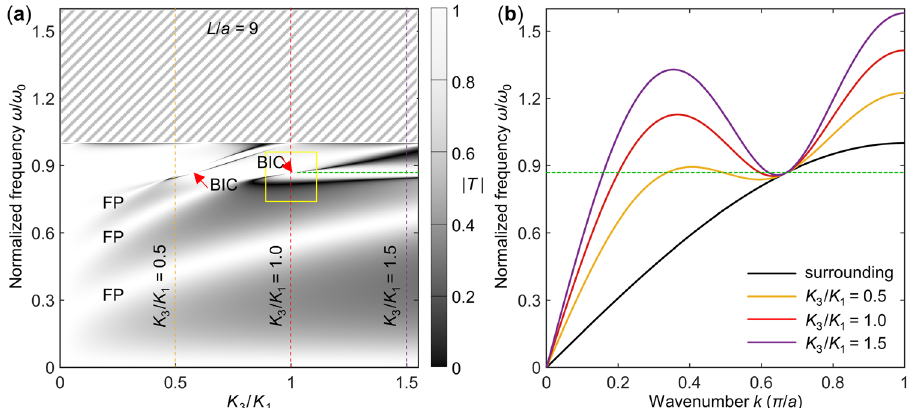
(cid:1) (cid:1) (cid:1) (cid:1) of the discrete nonlocal mass-and-spring- (cid:1) (cid:1) (cid:1) (cid:1)